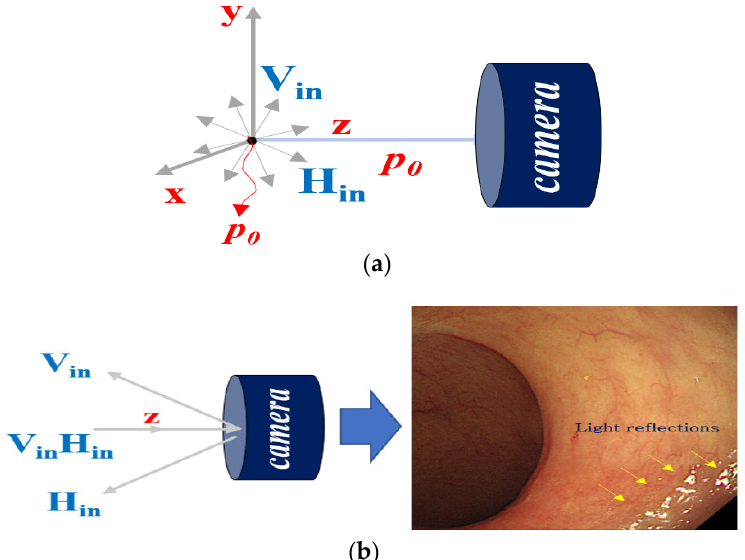
Figure 8. Generation of specular reflection in a camera. ( a ) incident of light polarization ( b ) generation of light reflection phenomenon.